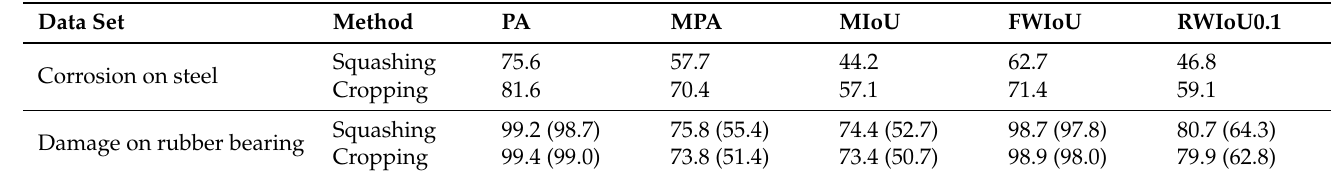
Table 3. Accuracy of Damage Segmentation.